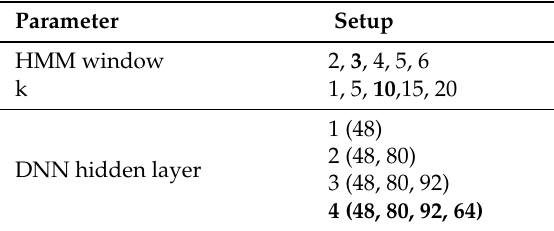
Table 4. Parameter setup (the default values are in